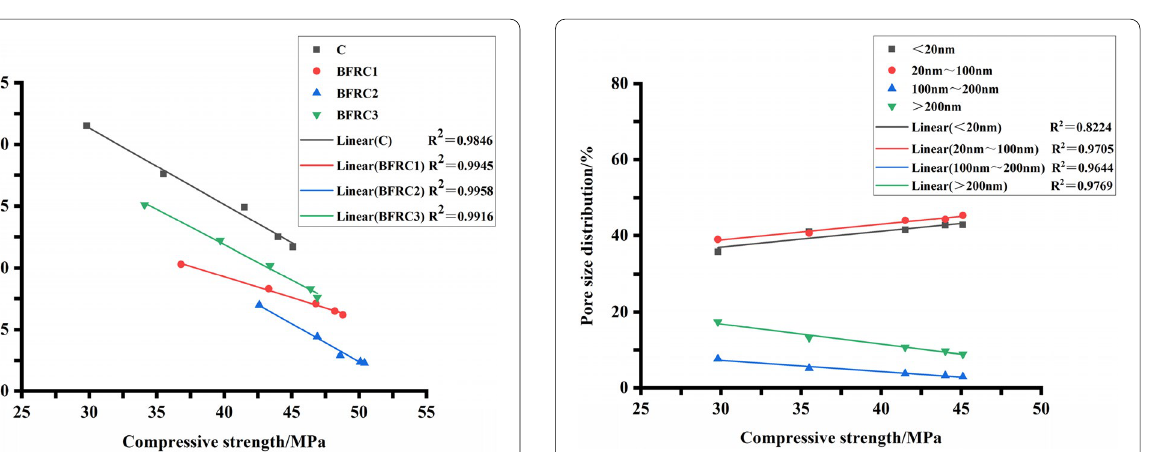
Fig. 17 Relationship between porosity and compressive strength.